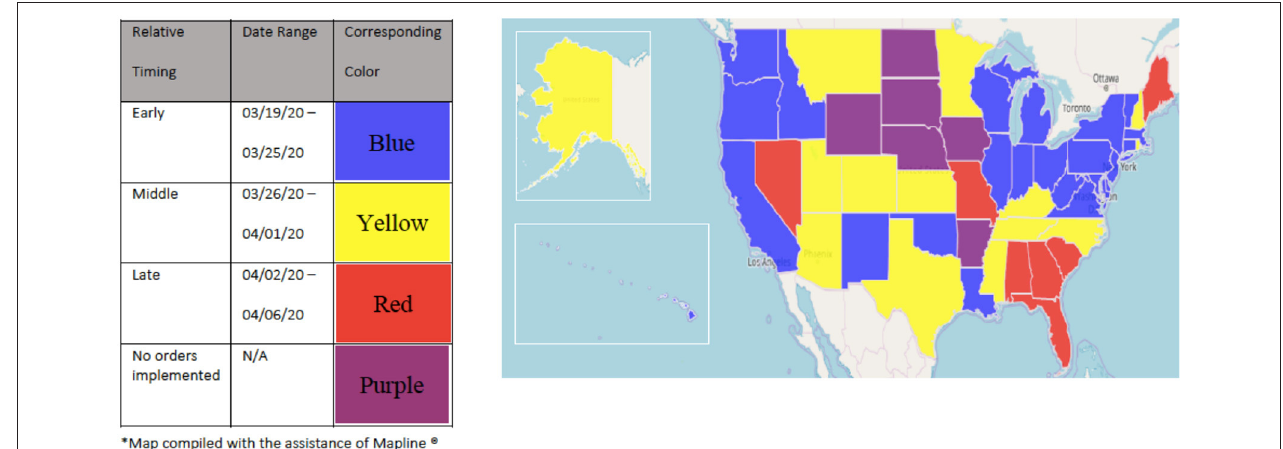
FIGURE 3 | Original stay-at-home